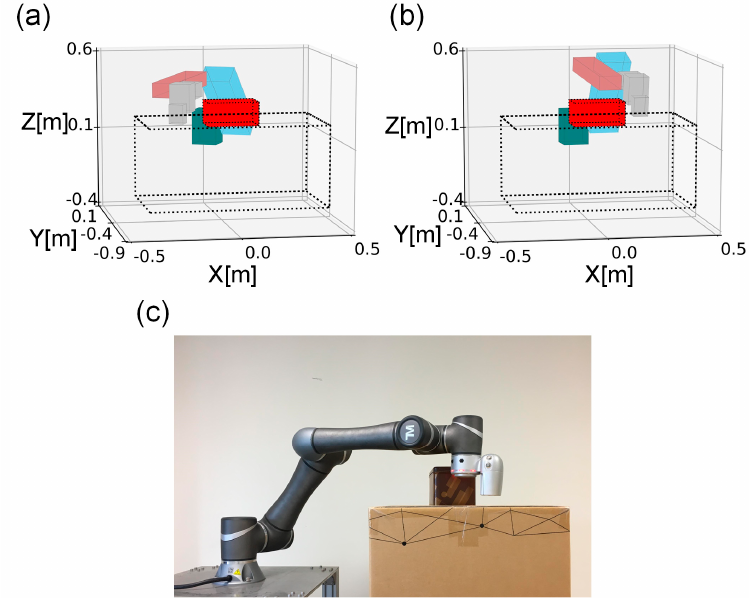
Figure 12. The ( a ) start and ( b ) end configurations of the manipulator in the experiment. The red shaded box is the obstacle placed on top of a desk, which is shown as transparent. The solid boxes represent the bounding boxes of the manipulator. ( c ) A photograph of the experimental setup. Table 4. The energy consumptions of the manipulator using human-taught and reinforcement learning (RL)-learned trajectories. Tester 1 Tester 2 Tester 3 RL Energy [J]